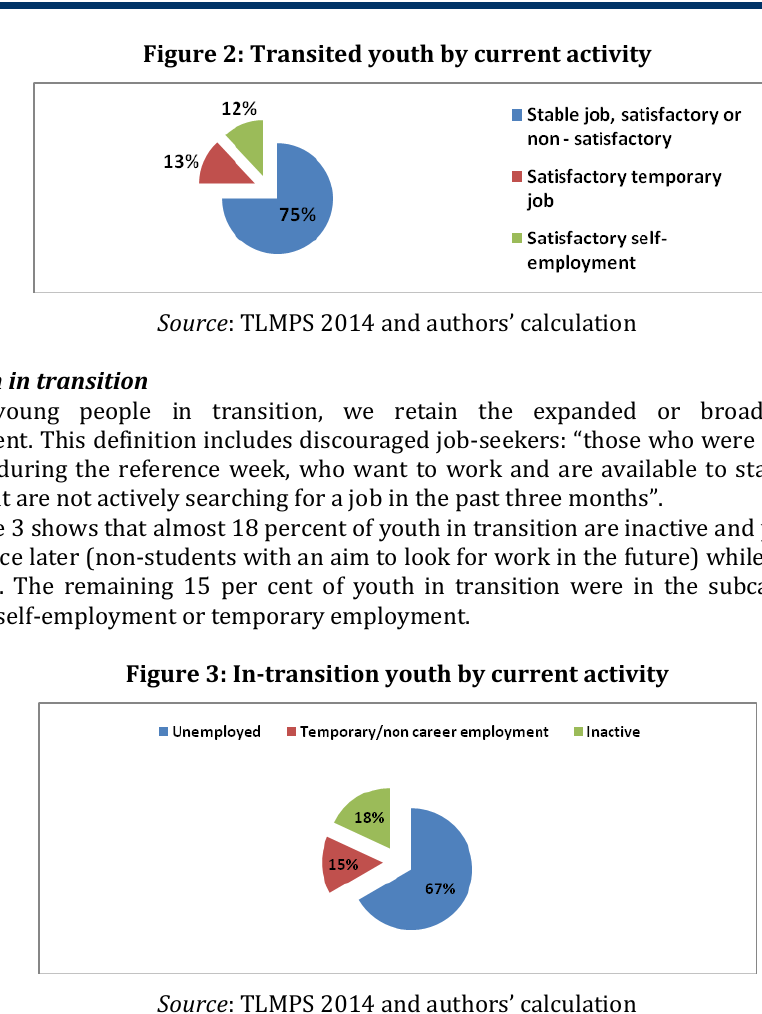
Figure 4: Youth who had not started the transition